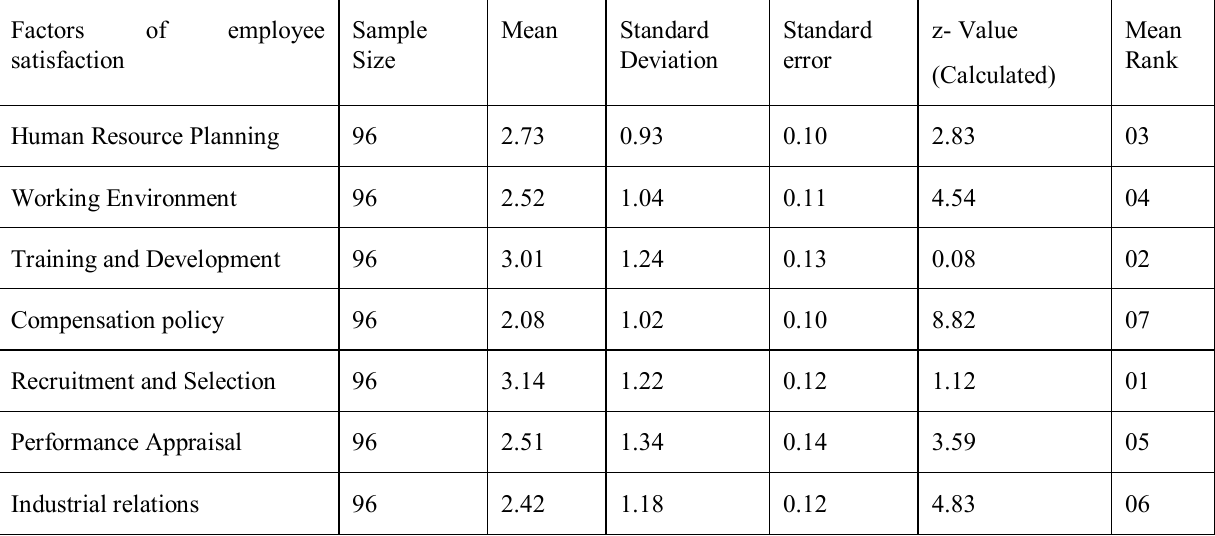
Table 2: Computation of z